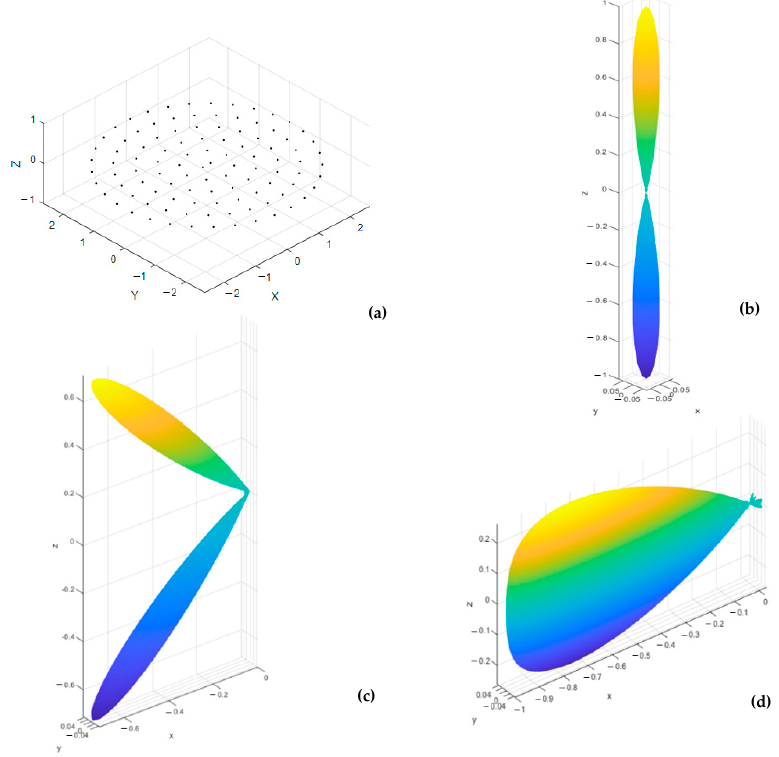
Figure 4. Uniform concentric circular array structure and beam characteristics at three mainlobe directions: ( a ) array structure, ( b ) normalized 3D power pattern for a mainlobe at (0°,180°) , ( c ) normalized 3D power pattern for a mainlobe at (45°,180°) , and ( d ) normalized 3D power pattern for a mainlobe at (90°,180°).